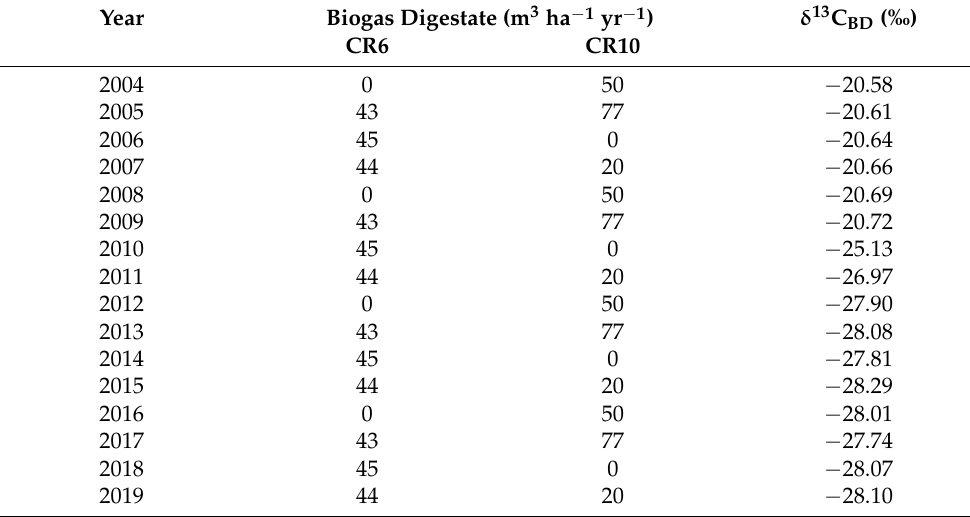
Table A1. Annual amounts of biogas digestate applied to fertilized plots of crop rotations CR6 (50 % maize) and CR10 (no maize), as well as δ 13 C values of the applied biogas digestate ( δ 13 C BD ) calculated from the fractions of C 3 and C 4 biomass used in the biogas plant and accounting for the terrestrial Suess effect